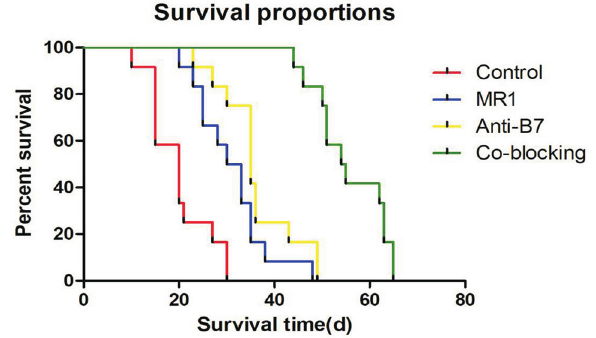
Figure 1 - Survival curve of transplanted corneal graft in different groups. (A) survival curve of rabbits in the control group; (B) survival curve of rabbits in the MR1 group; (C) survival curve of rabbits in the Anti-B7 group; (D) survival curve of rabbits in the co-blocking group. Compared with the control group, the co-blocking group displayed a significantly longer allograft survival time. Abscissa: survival time; Ordinate: percent of